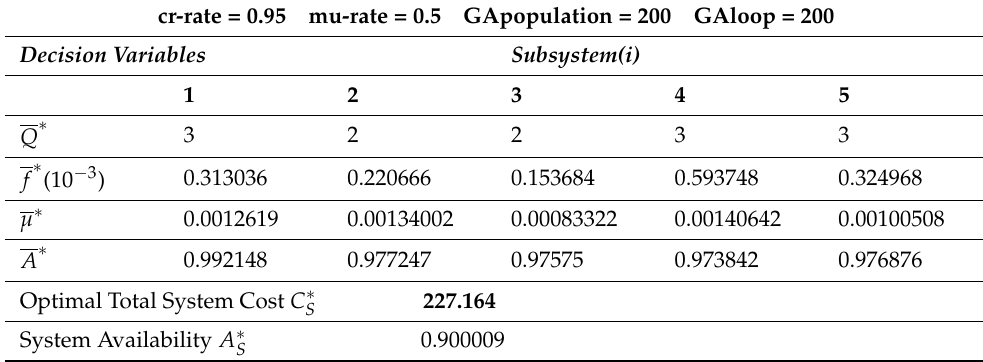
Table 36. Optimal Solutions obtained by ENUM–MGA combined method for the n -stage mixed system.